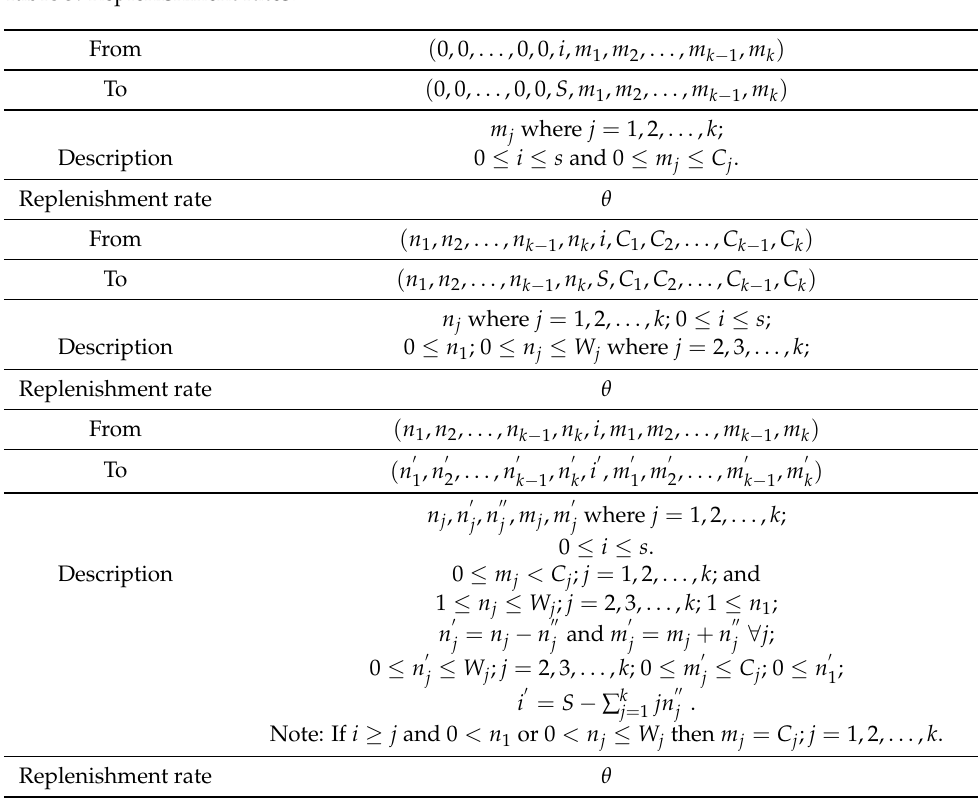
Table 3. Replenishment